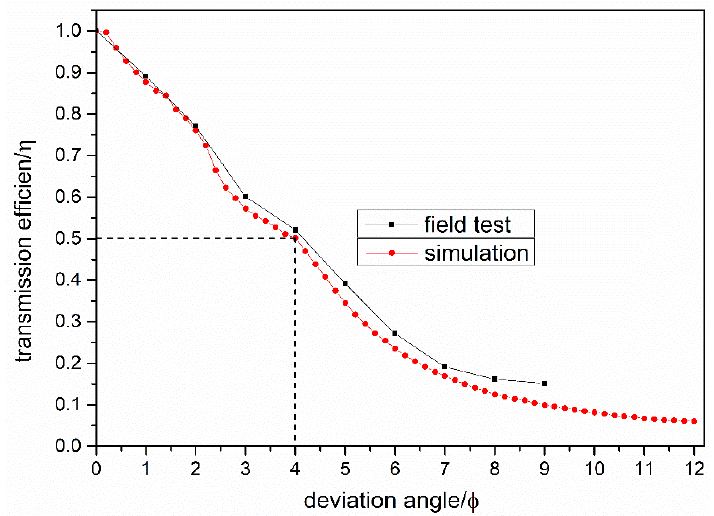
Figure 7. Variation curve of transmission efficiency of a receiving unit with a deflection angle.